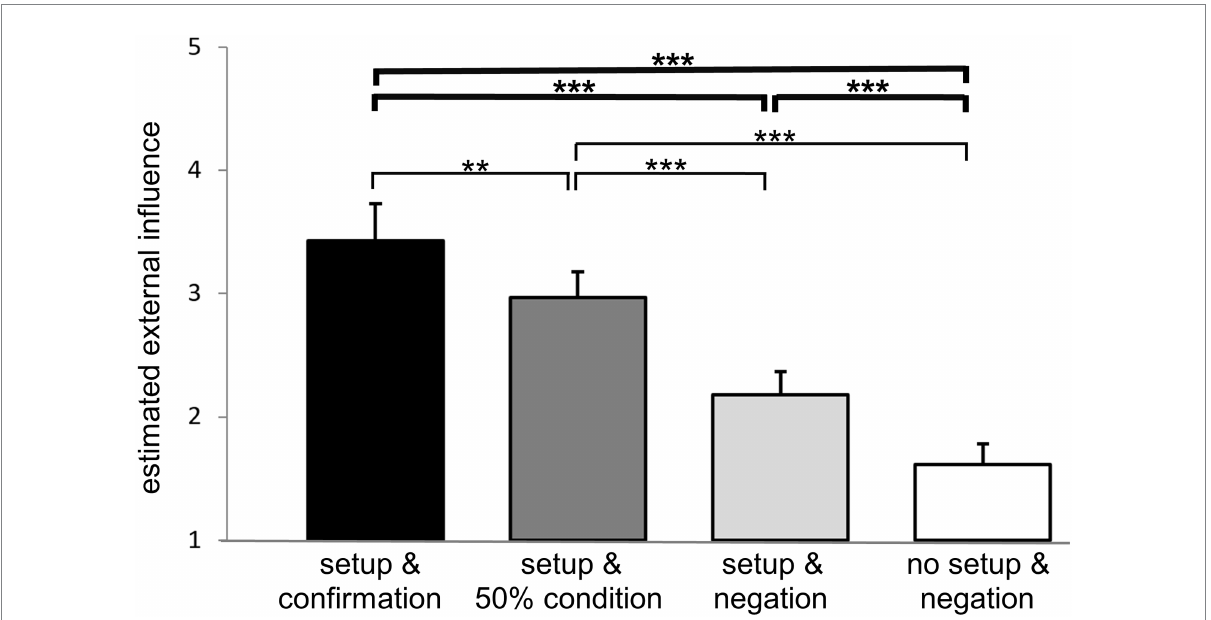
FIGURE 2 External influence estimation. Mean estimated external influence ratings of the participants for the four conditions tested are given in bars: “setup & confirmation” (black), “setup & 50% condition” (dark grey), “setup & negation” (light grey) and “no setup & negation” (white). Results of hypothesis driven analyses are marked with bold lines and asterisks above, exploratory analyses in slim lines and asterisks below. The intervention comprising setup and information has a significant impact on the estimation of external influence. Moreover, each of the two components, the setup as well as the information, contribute significantly to an increase of perceived external influence. Furthermore, exploratory analyses reveal significant differences also between the setup and 50% condition and each of the other conditions. ** p ≤ 0.005, *** p ≤ 0.001. Mean values and standard error of the means are